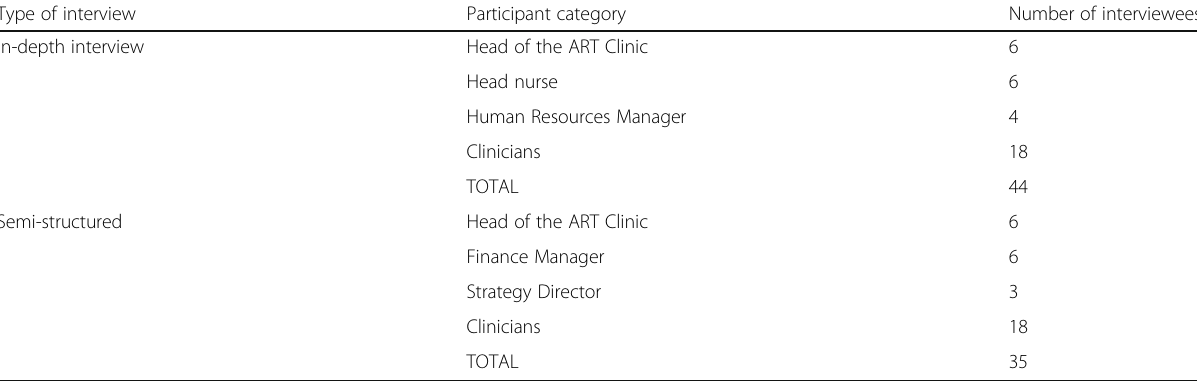
Table 3 Summary of participants for phase two of the study Type of